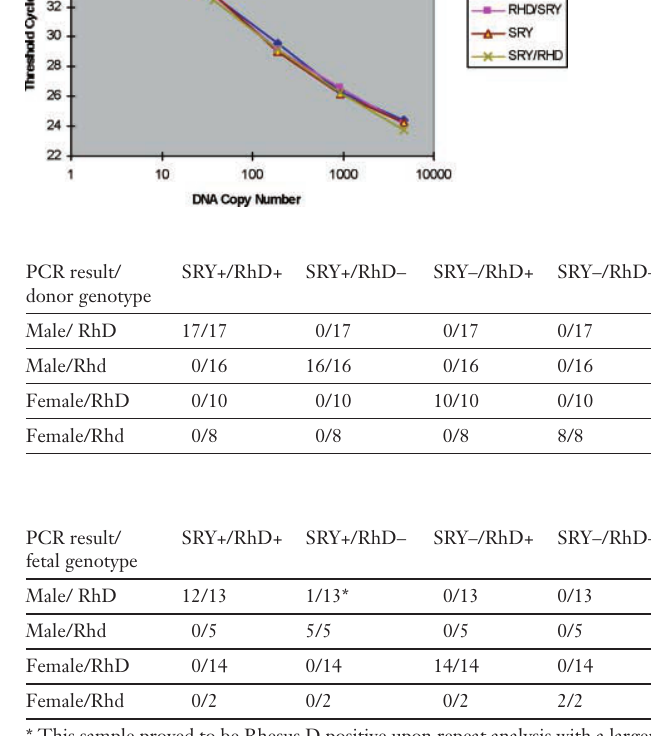
Correlation of amplification efficiency for the Rhesus D and SRY loci on a standard curve using single Rhesus D or SRY- specific real- time PCR as well as multiplex Rhesus D / SRY real-time PCR.